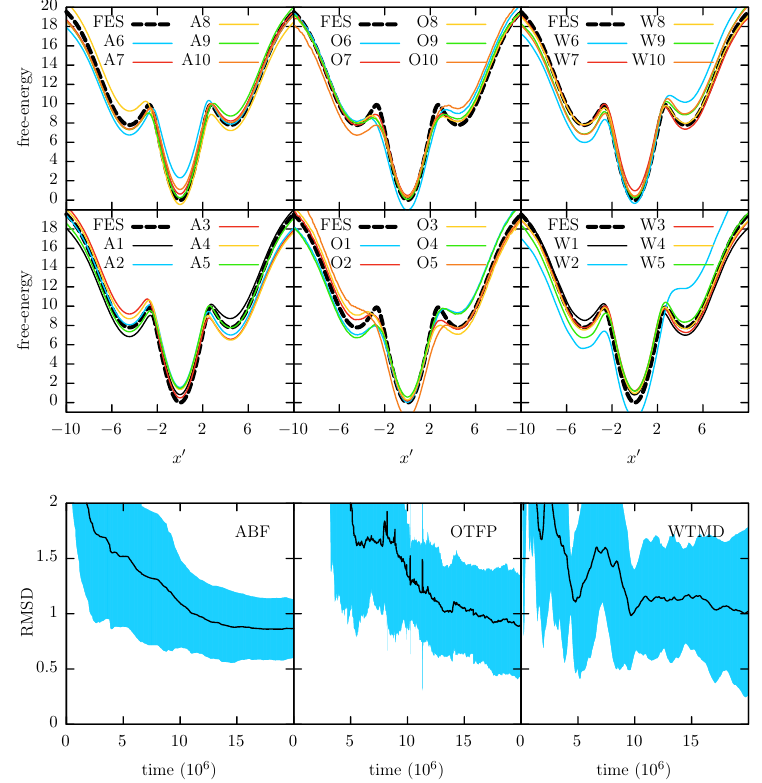
Figure 8. An scheme to show the prejudicial effect of the bias potential for the middle channel B transitions in the adaptive methods. In opposition to reduce the energy barrier at x (cid:48) = 0 the bias applied by ABF and WTMD helps to increase it.